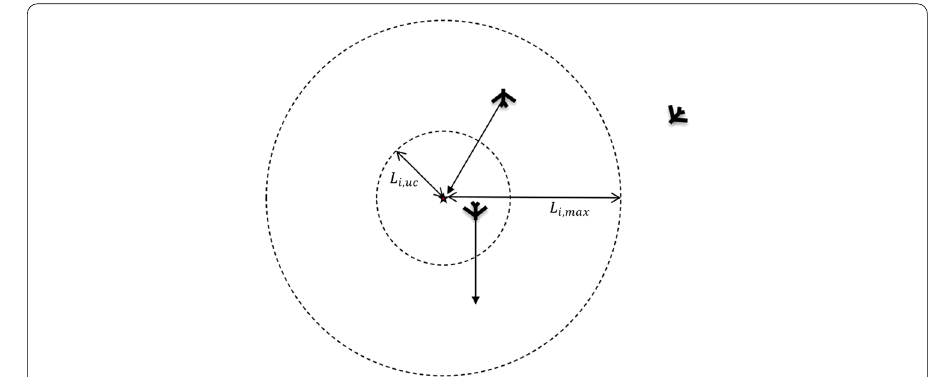
Fig. 2 Diagram of target attraction